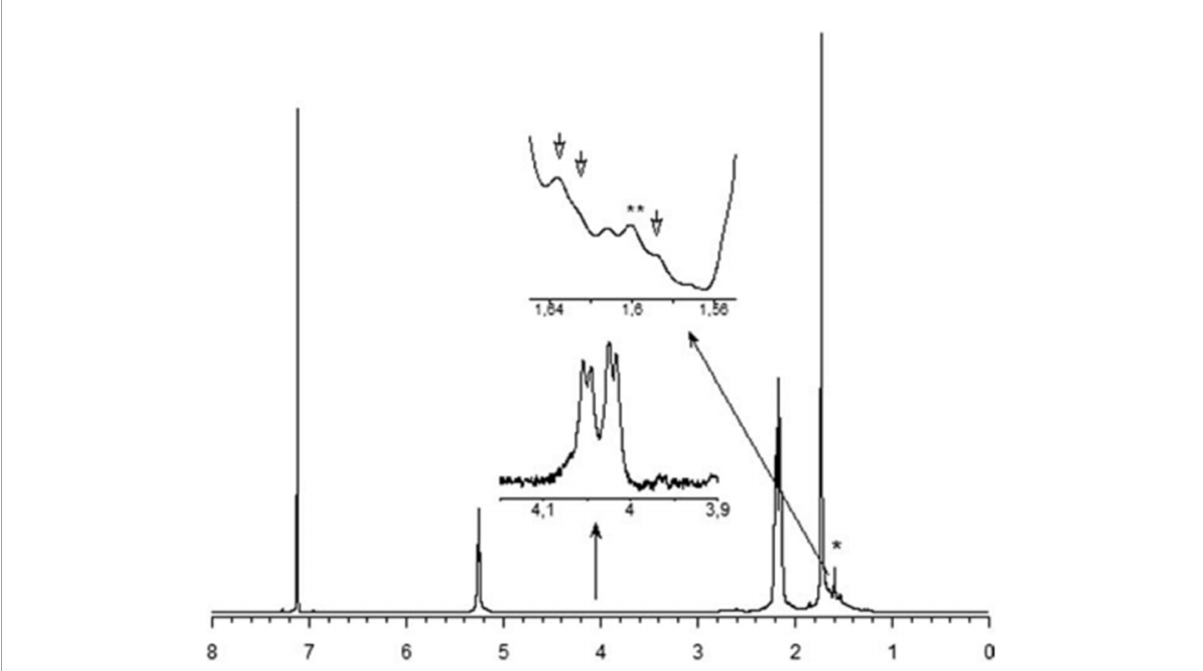
FIGURE9 The 1 H NMR spectrum of rubber extracted from E. characias latex. Peaks at 5.31, 2.17, and 1.73 ppm are attributed to the olefinic, methylene and methyl protons, respectively, of the cis-1,4-polyisoprene (Spanò et al., 2012). * and ** indicates 1 H NMR residual signal of cyclohexane (1.43 ppm) and methyl-protons of a trans-isoprene unit (1.62 ppm),